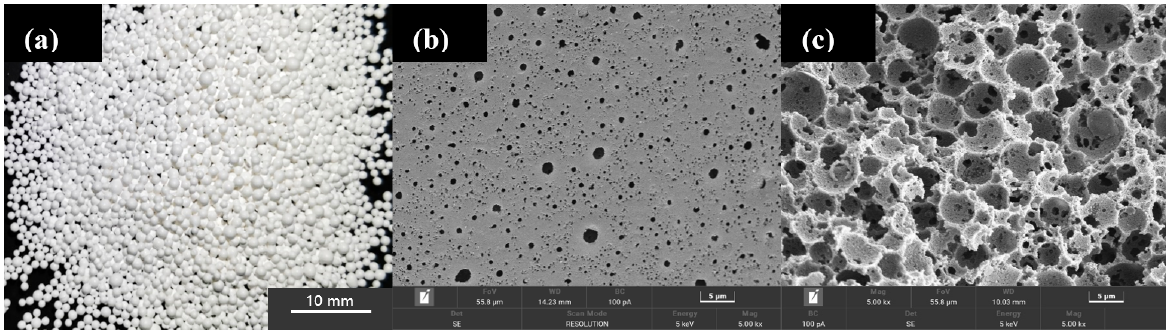
Figure 1. ( a ) Optical photograph of PA beads; ( b ) SEM image of the surface of PA beads; ( c ) SEM image of the cross-section of PA beads. image of the cross-section of PA